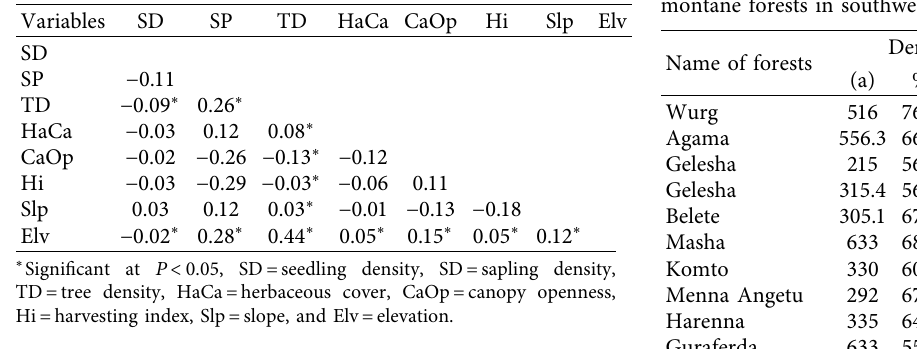
Hi � harvesting index, Slp � slope, and Elv � elevation.